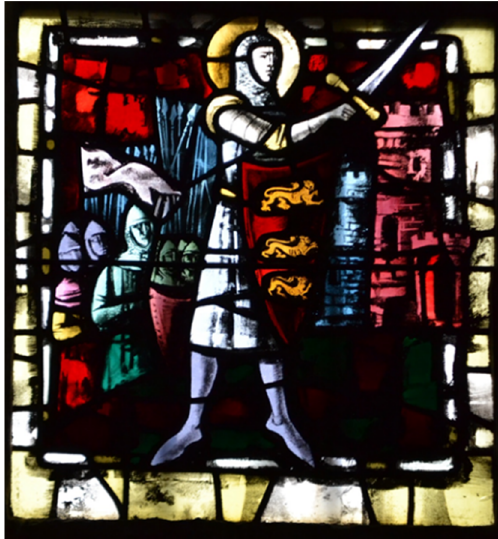
Figure 12. Saint-Lô, Church of Notre-Dame, Saint-Thomas chapel, Life of Saint Thomas window, 1968, detail, Chancellor Thomas leading troops into battle. © author.